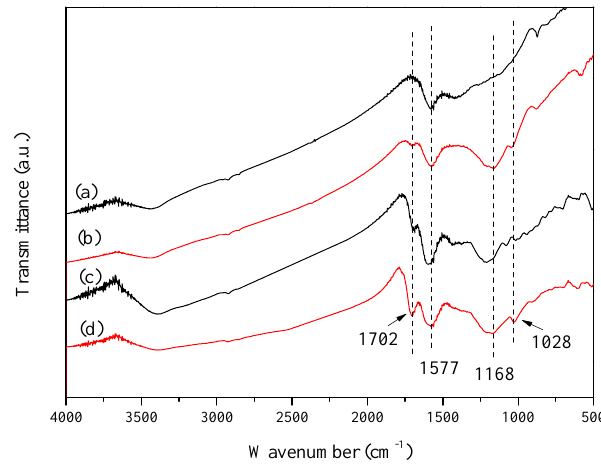
Figure 5. Fourier transform ‐ infrared (FT ‐ IR) spectra of carbon materials: ( a ) pre ‐ CSA; ( b ) CSA; ( c ) pre ‐ CSALA; ( d ) CSALA.